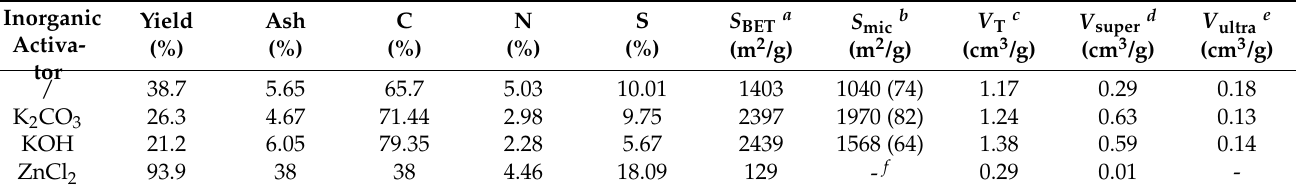
Table 1. NSC elemental compositions and textural characteristics of NSC produced with various types of inorganic activators. The activation conditions were set to be 700 ◦ C, inorganic activator: KSCN: biomass mass ratio =